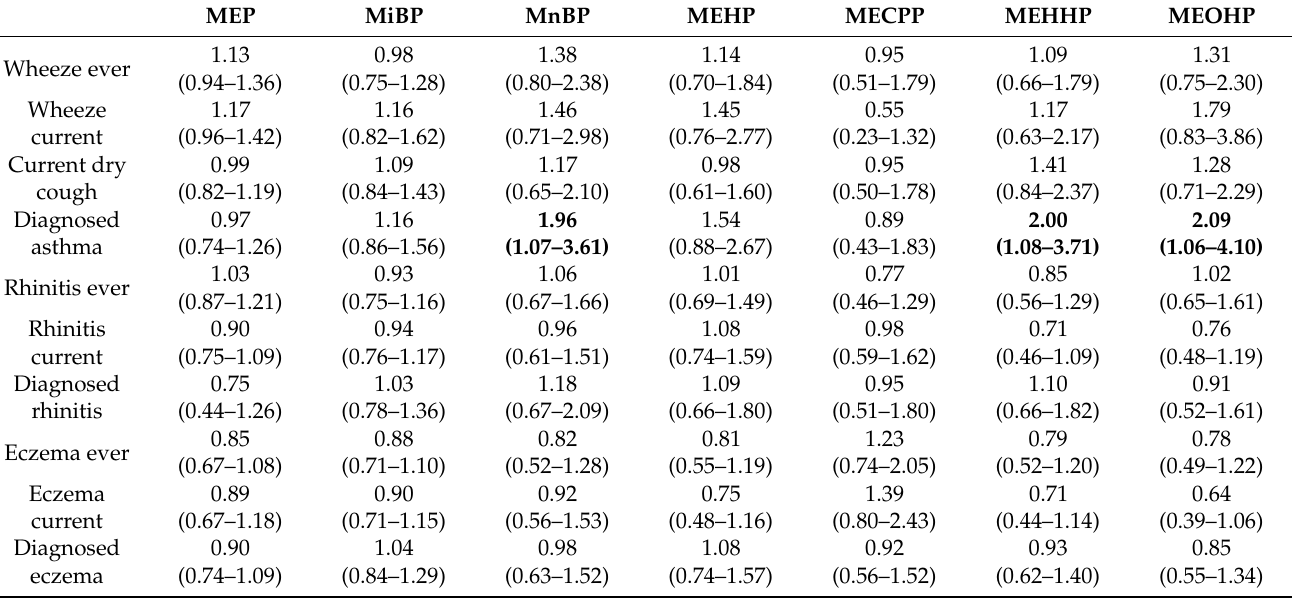
Table 4. Adjusted odds ratios (AOR) with 95% CIs of phthalate metabolites with children’s asthma and allergy in multivariate regression models.